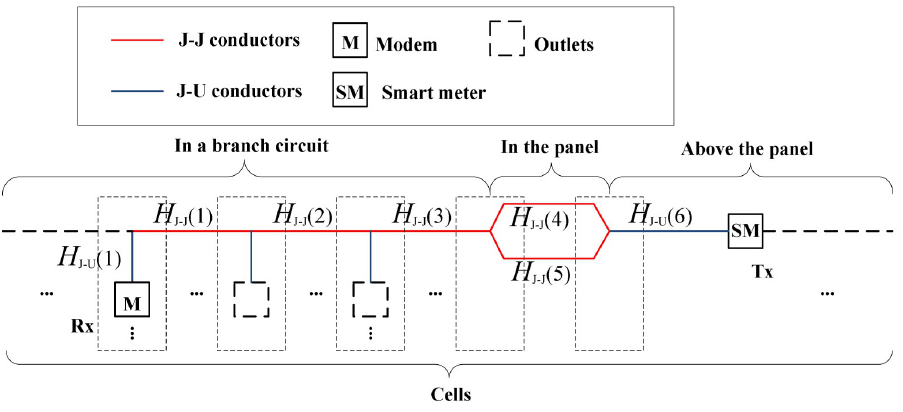
Figure 6. A simple topology divided into